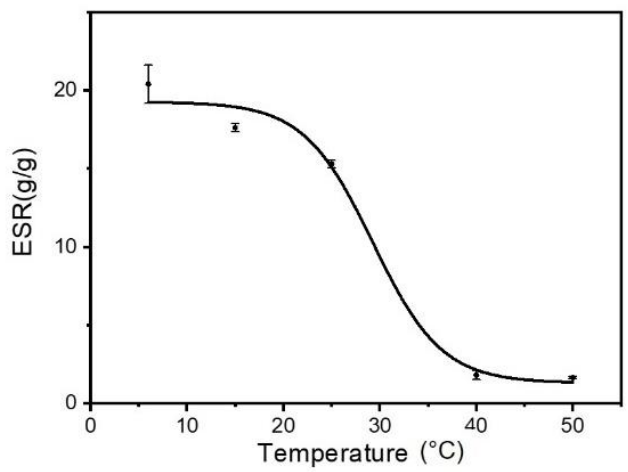
Figure 4. Equilibrium swelling ratio (ESR) of PVA10/(PVA-MA)-g-PNIPAM hydrogel in the temperature range of 6 to 50 °C.